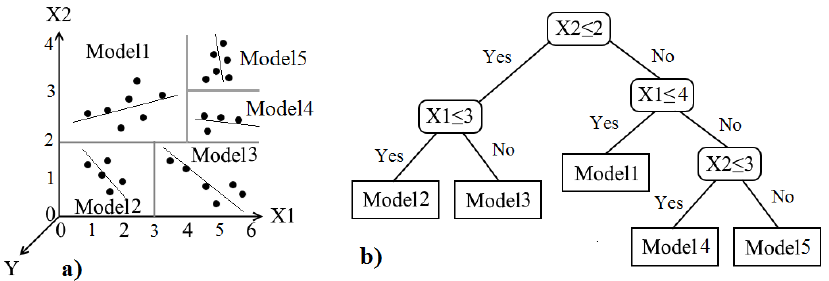
Figure 6. M5 tree model: ( a ) splitting the input datasets; ( b ) M5 tree model structure [101].